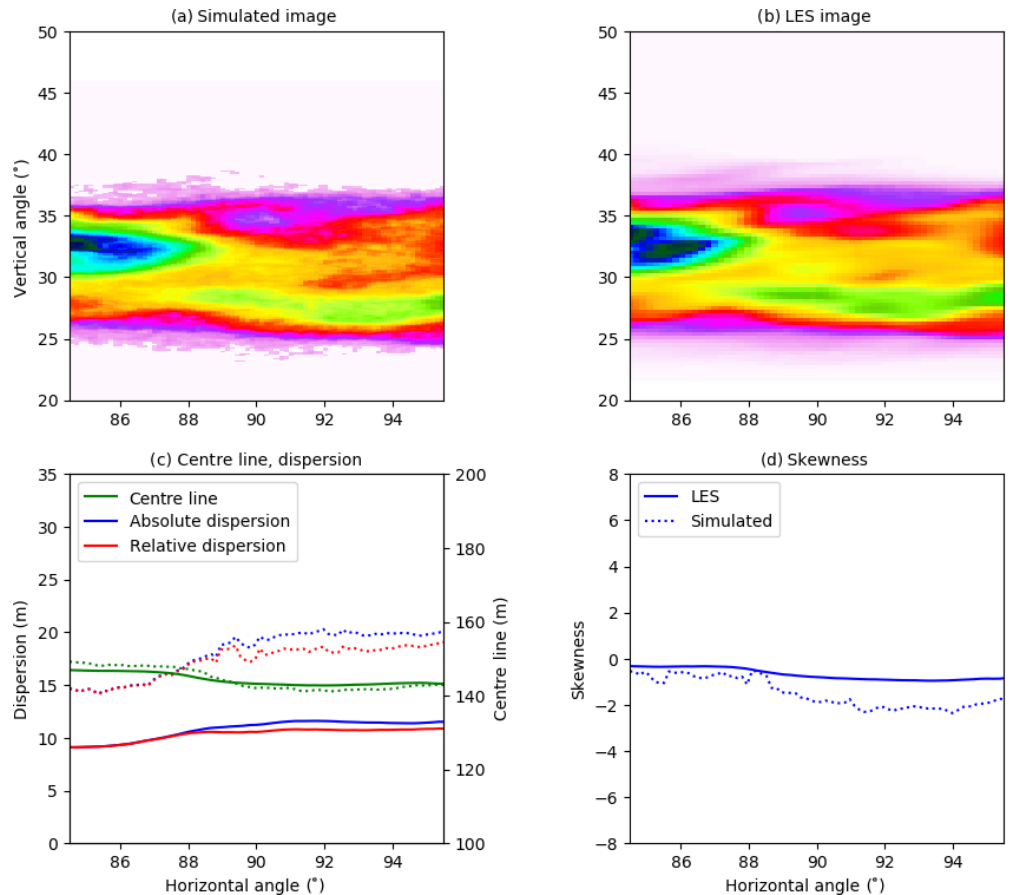
Figure 7. Similar to Fig. 4 but for camera D and time step